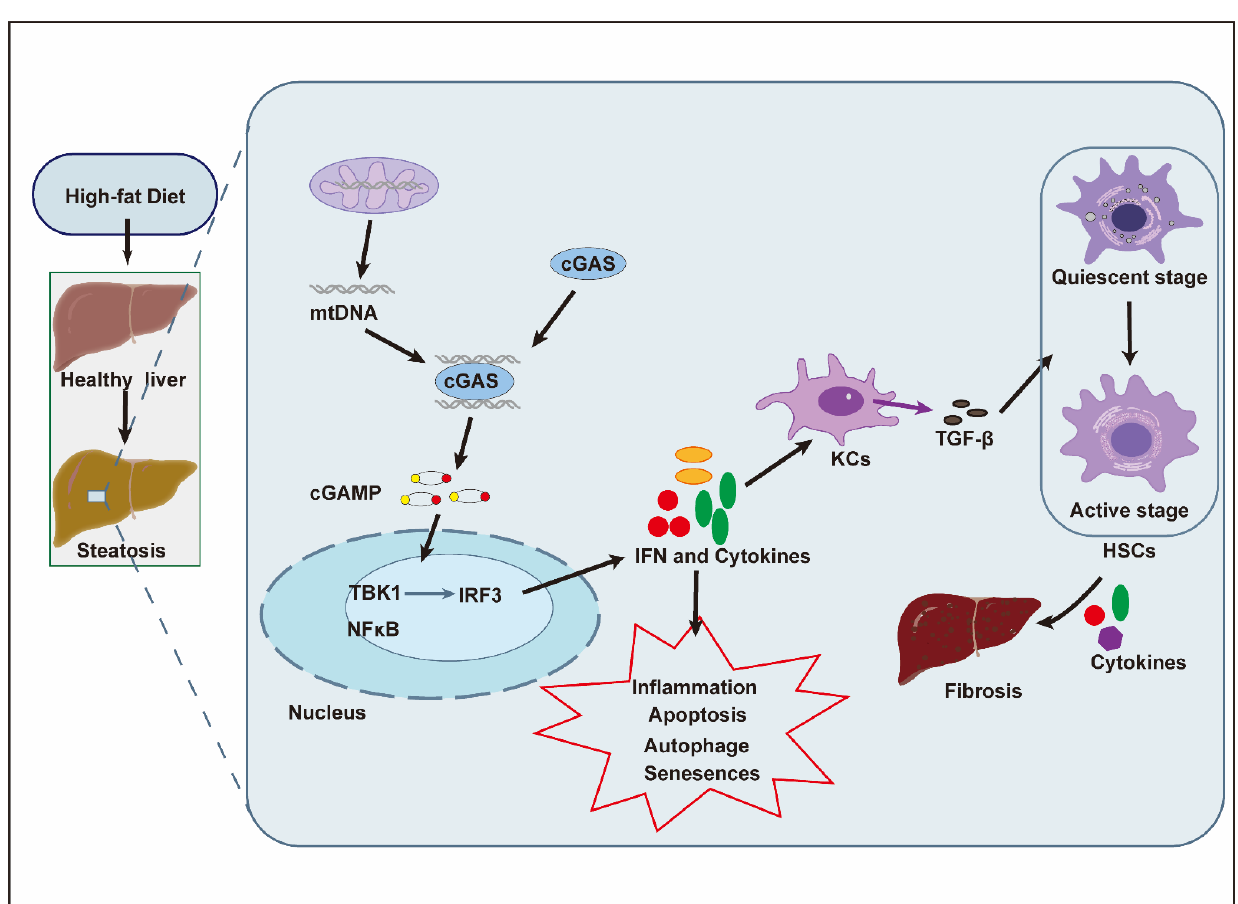
Figure 3. Role of the cGAS-STING pathway in HFD-induced NAFLD [22]. HFD-induced NAFLD manifests as steatosis, which leads to mitochondrial stress injury and the release of mitochondrial DNA (mtDNA) into the cytosol. Subsequently, the mtDNA is recognized by cGAS and produces cGAMP to activate the STING downstream pathways, including STING-TBK1-IRF3 and STING-NF- κB, which trigger the transcription of type-I IFNs and the production of pro-inflammatory cytokines, resulting in the hepatic inflammatory response. In addition, pro-inflammatory cytokines activate the function of macrophages/KCs and produce TGF- β, which activates HSCs and aggravates liver fibrosis in NASH .